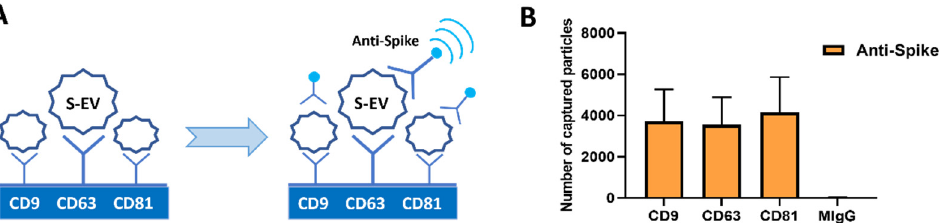
Figure 4. ExoView analysis of S-EVs. ( A ) Schematic representation of S-EVs detection process for ExoView technique. ( B ) Number of S-EVs captured on CD9, CD63, CD81 or MIgG spots fluorescently labeled by anti-spike ab in APC obtained by ExoView analysis. The graph shows the average of three independent experiments ± SD.